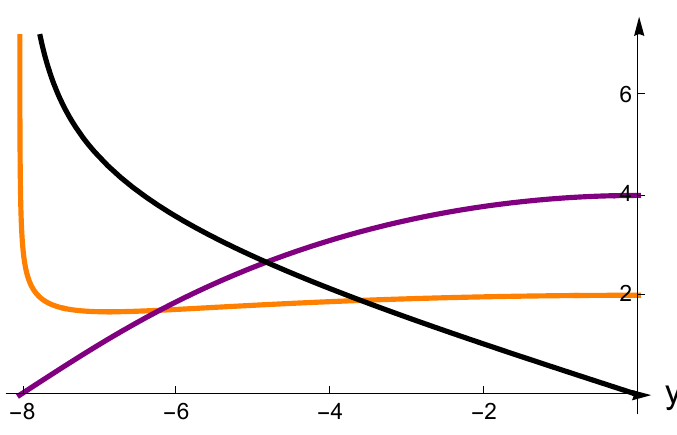
Figure 1 . A numerical solution with M 6 nearly-Kähler, interpolating between an O8-plane on the left, and a regular (or conical G singularity) on the right. The functions are e A (orange), e C 2 (black), h (purple). The parameters in (6.32) in this case are a = 2 , m = 1 0